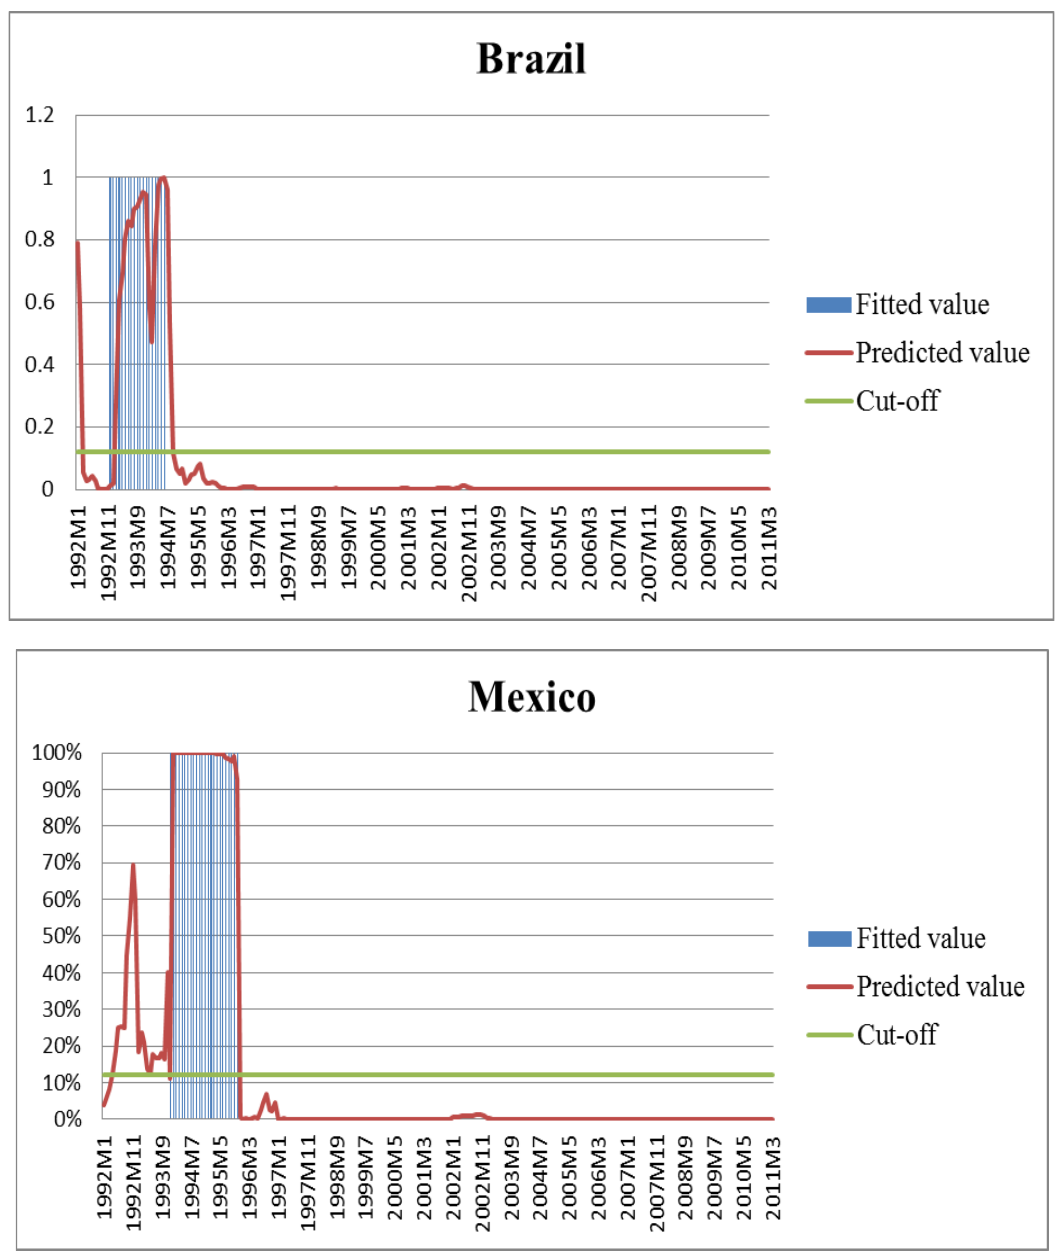
Figure 6 fit the actual and predicted values of four Latin American countries. This indicates that the EWS model detected signals before the actual currency crises in Mexico and Argentina in 1994–1995, and in Argentina in 2001–2002. It also confirms that these countries did not face crises during 2007–2008, and until the end of